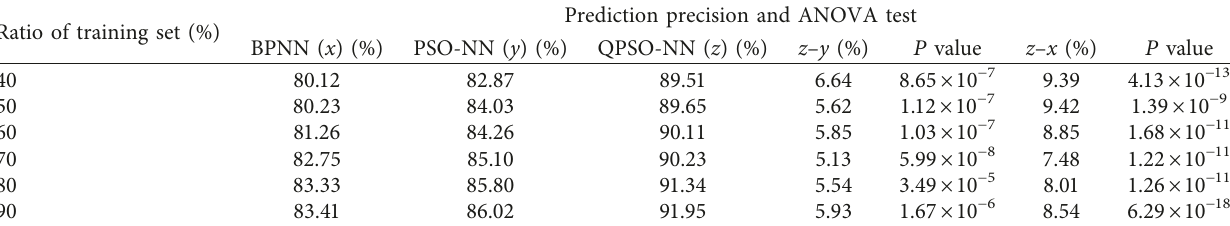
Table 3: Comparison on prediction among the QPSO-NN, PSO-NN, and BPNN. Ratio of training set (%)